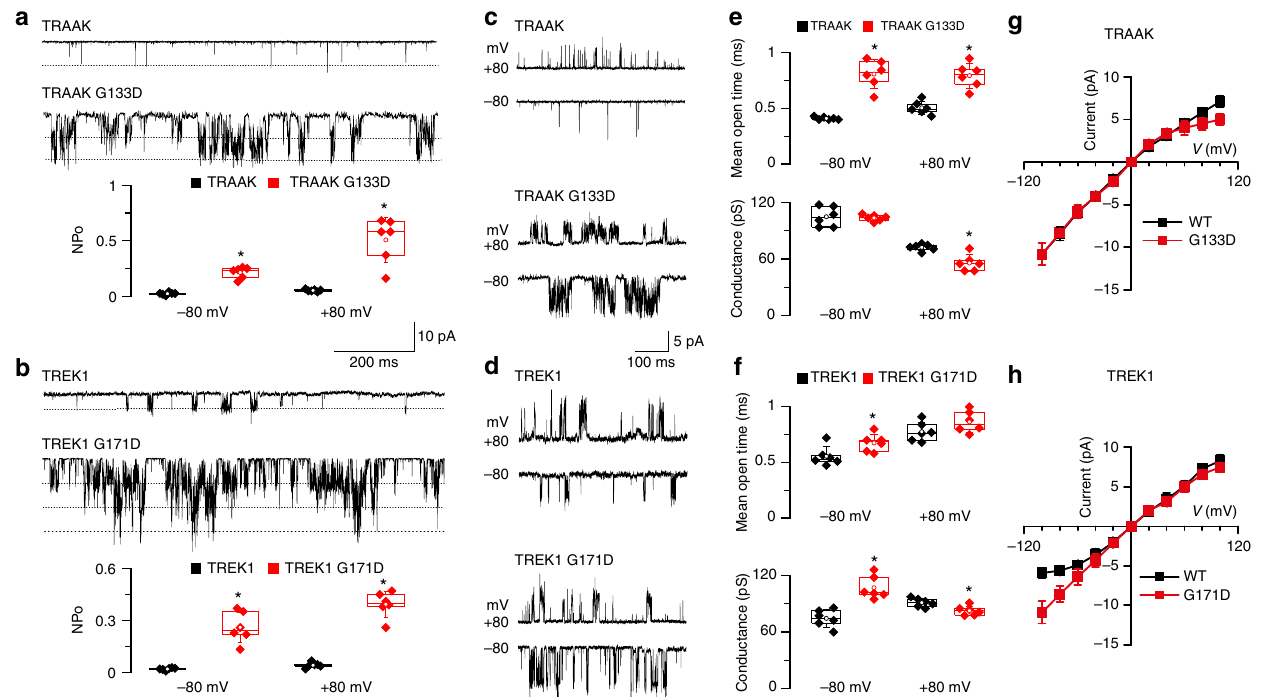
Fig. 4 TM2.6 mutations in TRAAK and TREK1 increase single-channel open probability. a , b Channel opening of TRAAK, TRAAK G133D, TREK1, and TREK1 G171D at − 80 mV. Channel activity was determined by NPo analyzed at − 80 and + 80 mV. c , d Single-channel openings of TRAAK, TRAAK G133D, TREK1 and TREK1 G171D at two membrane potentials. Currents were recorded in cell-attached patches held at pipette potentials of + 80 and − 80 mV. Pipette and bath solutions contained 150 mM KCl. e , f Mean open time for TRAAK, TRAAK G133D, TREK1, and TREK1 G171D. Average unitary conductance for TRAAK, TRAAK G133D, TREK1, and TREK1 G171D. g , h Current – voltage relationships of single channels. Mean ± standard deviation. Source data are provided as a Source Data fi le. Each data point represents one recording; center lines, medians; open circles, means; box limits, 25th and 75th percentiles; whiskers, standard deviation. Mann – Whitney, n = 6, * p <